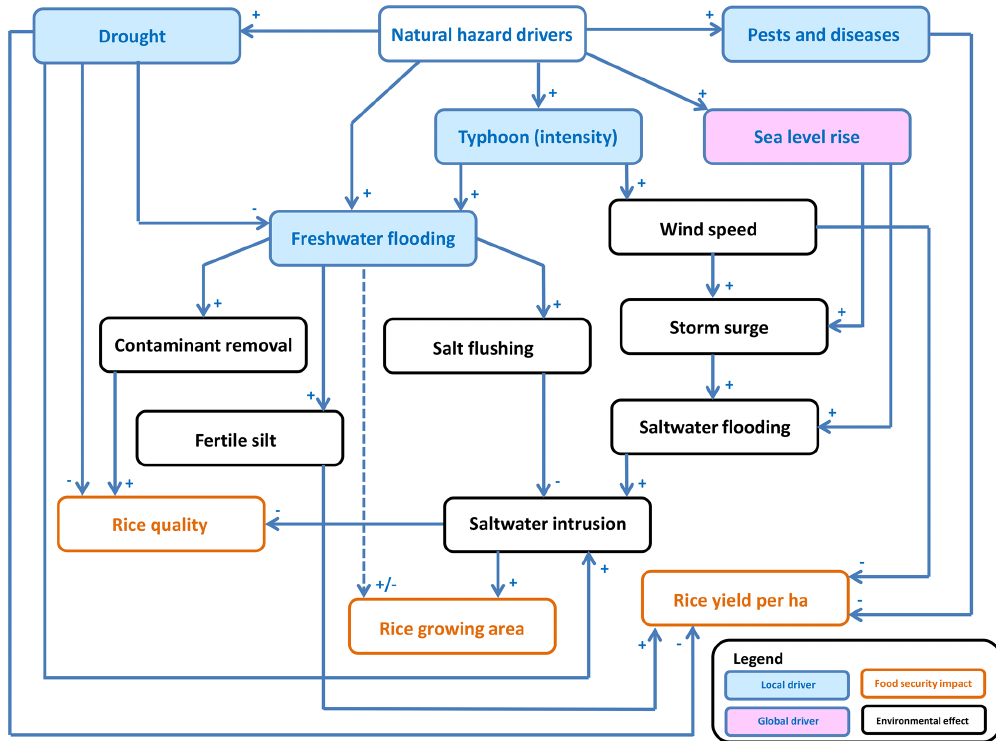
Figure 6. Flow diagram showing the natural hazards that affect rice production in the two mega-deltas of Vietnam. Local drivers refer to natural hazards that occur within the two mega-deltas. Although sea level rise has implications on a local scale, it is considered a global driver as it occurs on a global scale. The effect of flooding on rice growing areas is variable as other factors that affect crop mortality include the type of rice grown, the stage of rice growth, and the depth and length of submergence in